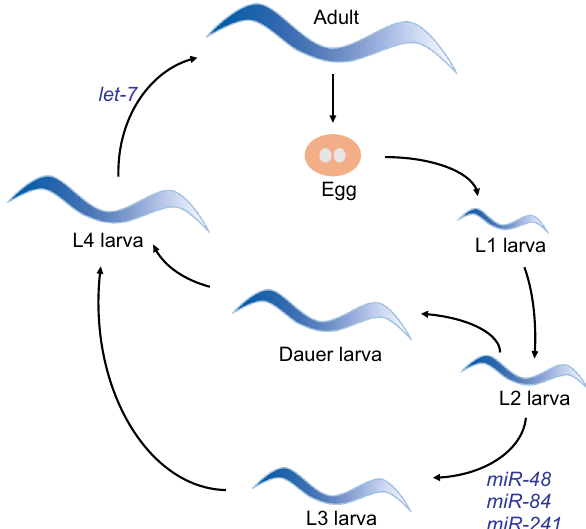
Figure 1. Life cycle of the nematode, Caenorhabditis elegans . Schematic diagrams of the C. elegans life cycle. Eggs laid by adult C. elegans go through four developmental stages: L1, L2, L3, and L4 larva. If the environment is harsh, L2 larva can go through the Dauer larva stage instead of the L3 larva stage. During the life cycle of C. elegans , miR-48 , miR-84 , and miR-241 regulate the L2-to-L3 transition, whereas let-7 regu- lates the L4-to-adult